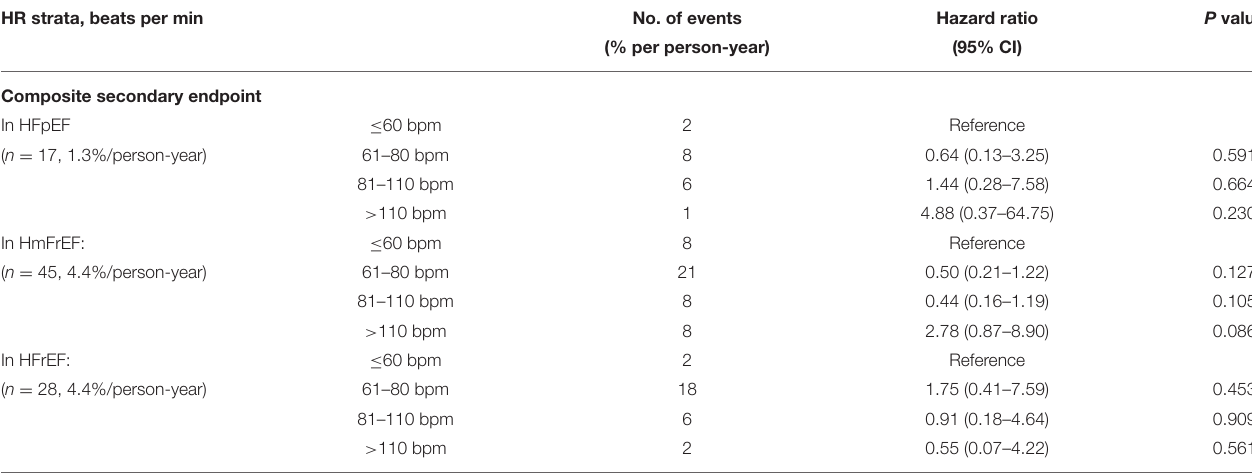
TABLE 3 | Cox regression analyses of the effect of the heart rate on the secondary endpoint. HR strata, beats per